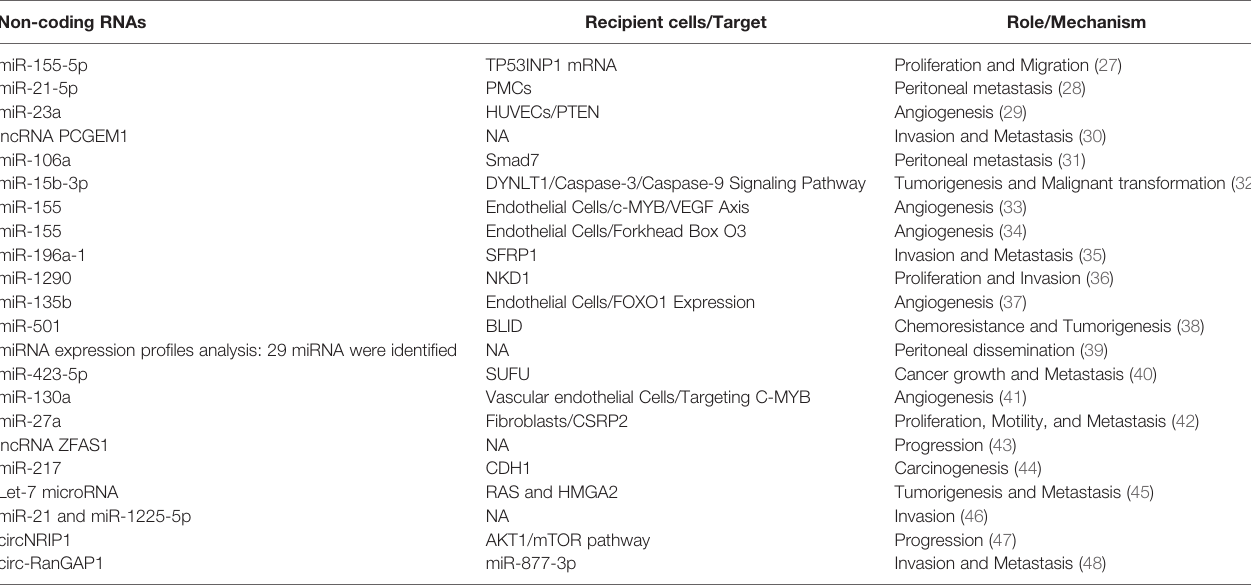
TABLE 2 | Summary of non-coding RNAs in EVs involved in GC progression and metastasis. Non-coding RNAs